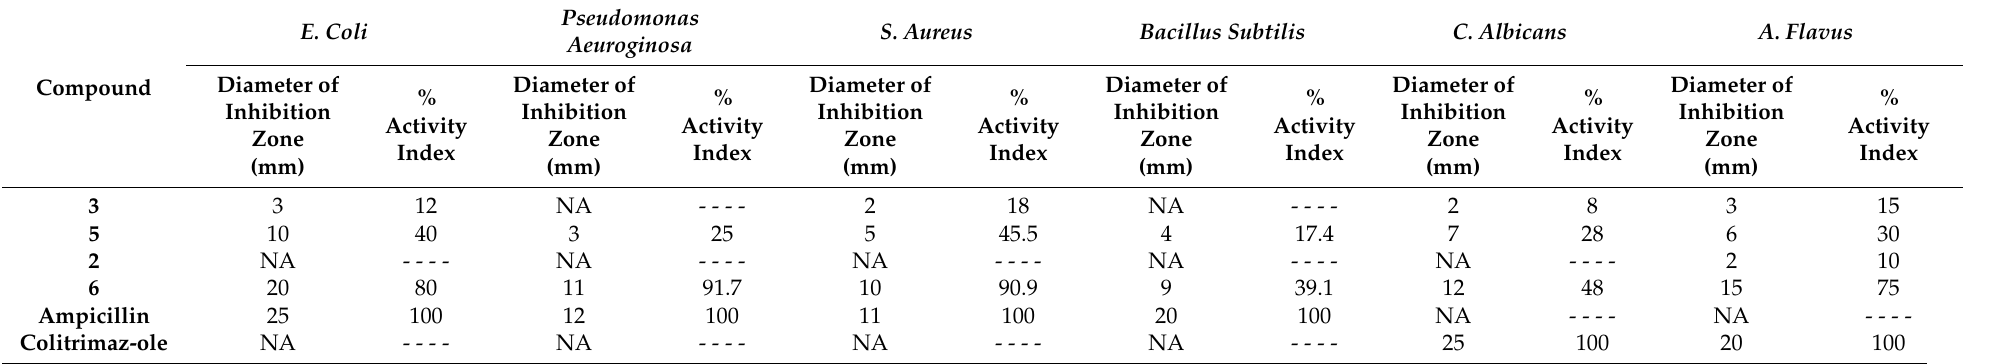
Table 2. In vitro antibacterial and antifungal screening of the newly synthesized